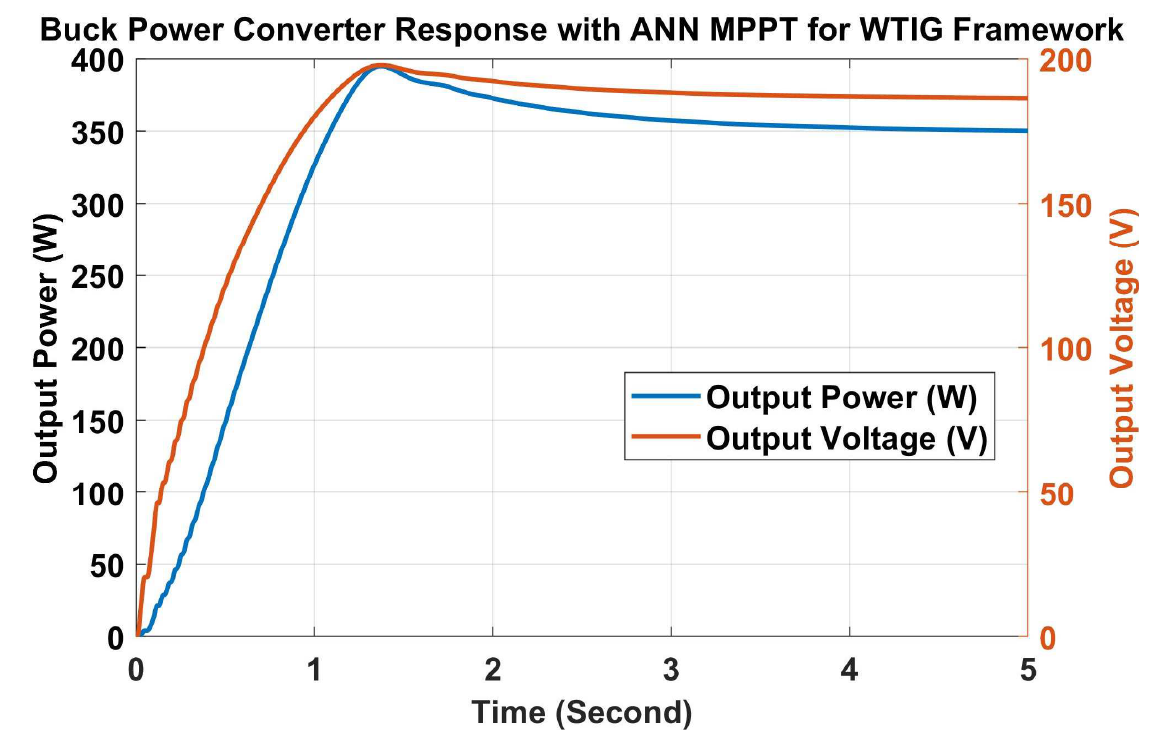
Figure 24. Output Power and Voltage of Boost Power Converter with AN-N MPPT for PV Frame- work.